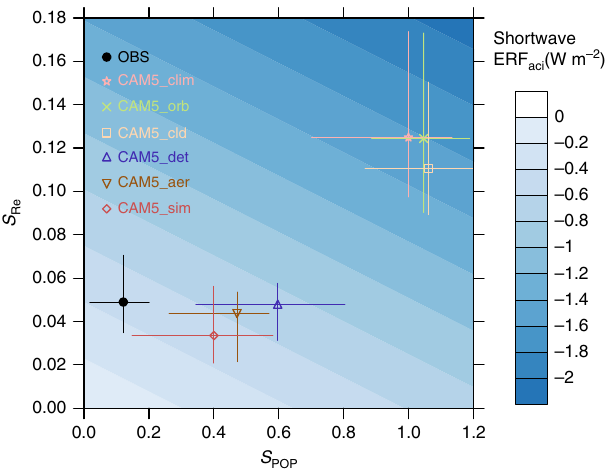
Fig. 1 Global mean susceptibility of cloud droplet size, susceptibility of precipitation probability, and effective radiative forcing due to aerosol-cloud interactions. Estimates of S Re = − ∂ ln( R e )/ ∂ ln(CCN) 18 , S POP = − ∂ ln(POP)/ ∂ ln(CCN) 6 , and the inferred ERF aci are derived from satellite retrievals and CAM5 model simulation when accounting for sampling and retrieval limitations. Observational estimates are derived from satellite-retrieved data products at the 20 km footprints of the Cloud and Earth ’ s Radiant Energy System (CERES) from CERES-CALIPSO-CloudSat-MODIS (C3M) 70, 71 . Model estimates are derived from conventional sampling of model fi elds (CAM5_clim) and incrementally accounting for orbital sampling (CAM5_orb), cloud clearing (CAM5_cld), aerosol detection threshold (CAM5_det), aerosol extinction retrieval (CAM5_aer), and cloud retrieval uncertainties using CALIPSO, CloudSat, and MODIS cloud simulators (CAM5_sim). Vertical and horizontal bars represent the range of S Re and − 2 . Blue shaded background S POP for a range of LWP from 20 to 200 g m represents ERF aci estimates as a function of S Re and S POP derived from a Fig. 2 Scatter plots and linear regressions of natural logarithm of effective series of CAM5 sensitivity simulations 6 . See Methods for radius against natural logarithm of aerosol optical depth. Data points are from a CAM5_orb and b CAM5_det simulations at CERES footprints over the globe (See Methods for details on sampling at CERES footprints), with LWP between 20 and 25 g m − 2 . Results for the other LWP bins show the mean AOD reduction of − 0.011 ( − 10%) for all-sky (Supple- same characteristics. The differences between CAM5_orb and CAM5_det mentary Fig. 1) and − 0.007 ( − 5%) for cloudy-sky (Supplemen- are caused by the cloud clearing and the aerosol detection threshold procedures. For better visualization of the scatter plots, AOD and R e on every fi fth CERES footprint along the satellite orbit are plotted. The